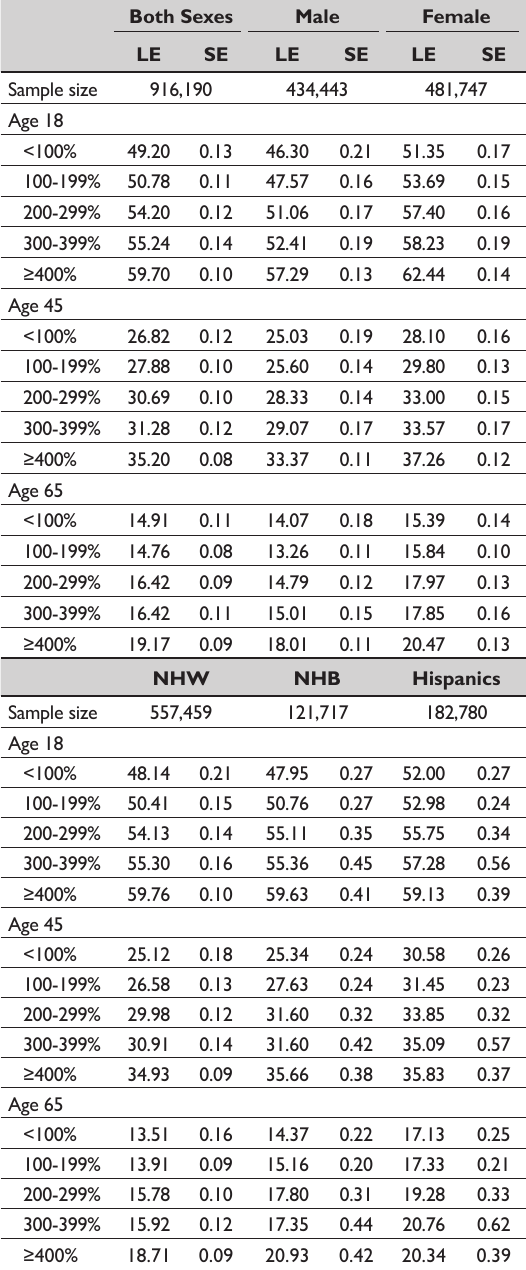
Table 2: Estimated life expectancies at selected ages at baseline by poverty status 1 , United